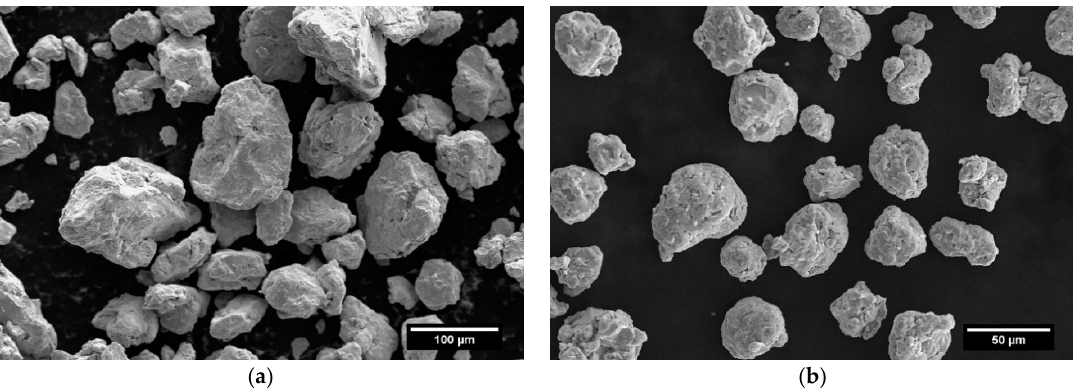
Figure 3. Scanning Electron Microscope (SEM) images of the powder after ( a ) 1 h and ( b ) 90 h of MA in nitrogen.